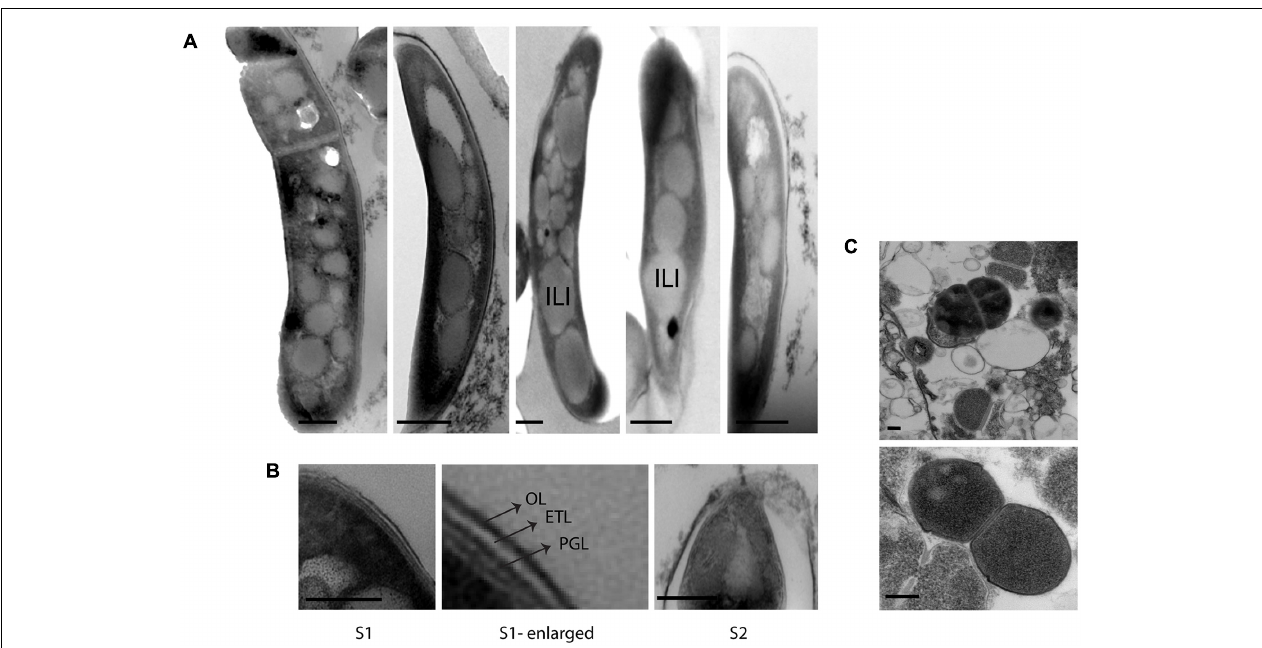
FIGURE 1 | Cellular ultrastructure of M. tuberculosis cells from patient sputum samples. (A) TEM images of M. tuberculosis cells with intracytoplasmic lipid inclusions in sputum sample S1. (B) TEM images of M. tuberculosis cells with detailed ultrastructure of cell envelope layers OL, ETL, and PGL from two different sputum samples S1 and S2. (C) TEM images of other bacterial cells in sputum sample S1. OL, outer layer; ETL, electron transparent layer; PGL, peptidoglycan layer; ILI, intracytoplasmic lipid inclusions; TEM, transmission electron microscopy. Scale bar = 200 nm.